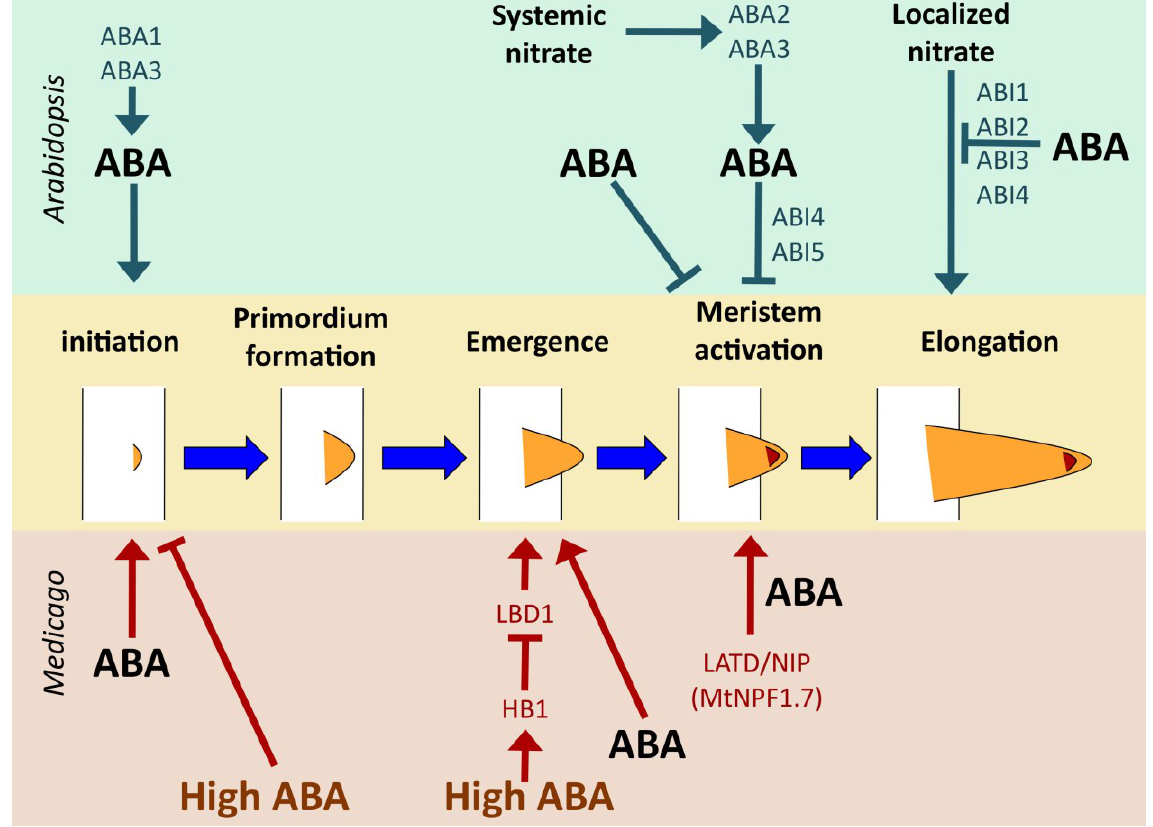
Figure 1. Regulation of lateral root development by ABA in Arabidopsis and Medicago